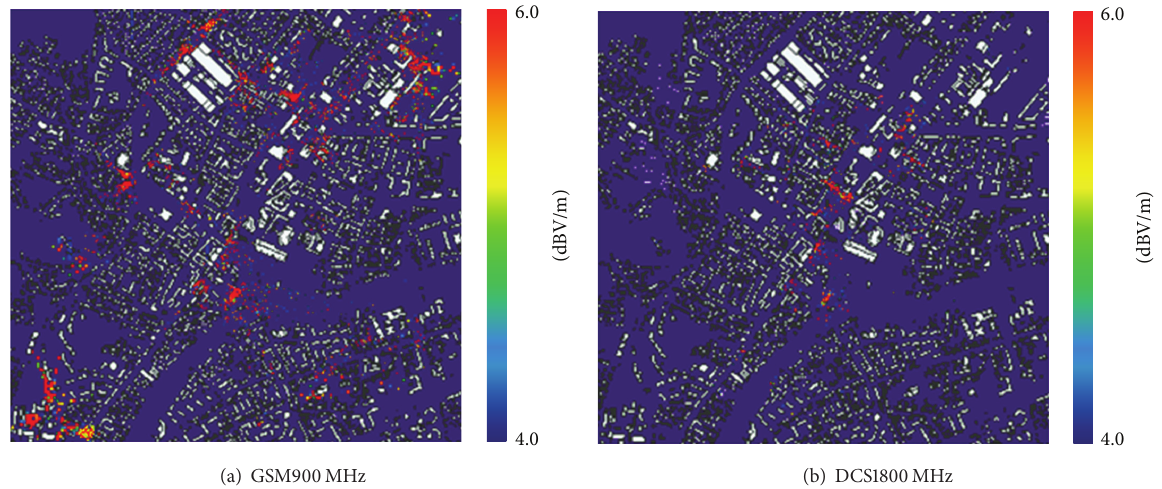
Figure 12: Maps of maximum values of total electric field strength for GSM900 and DCS1800 mobile services.